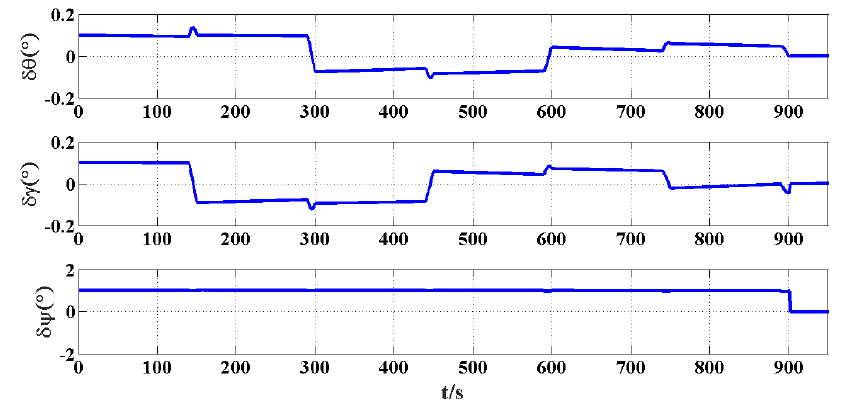
Figure 7. Attitude error of in-motion alignment of circular maneuver.